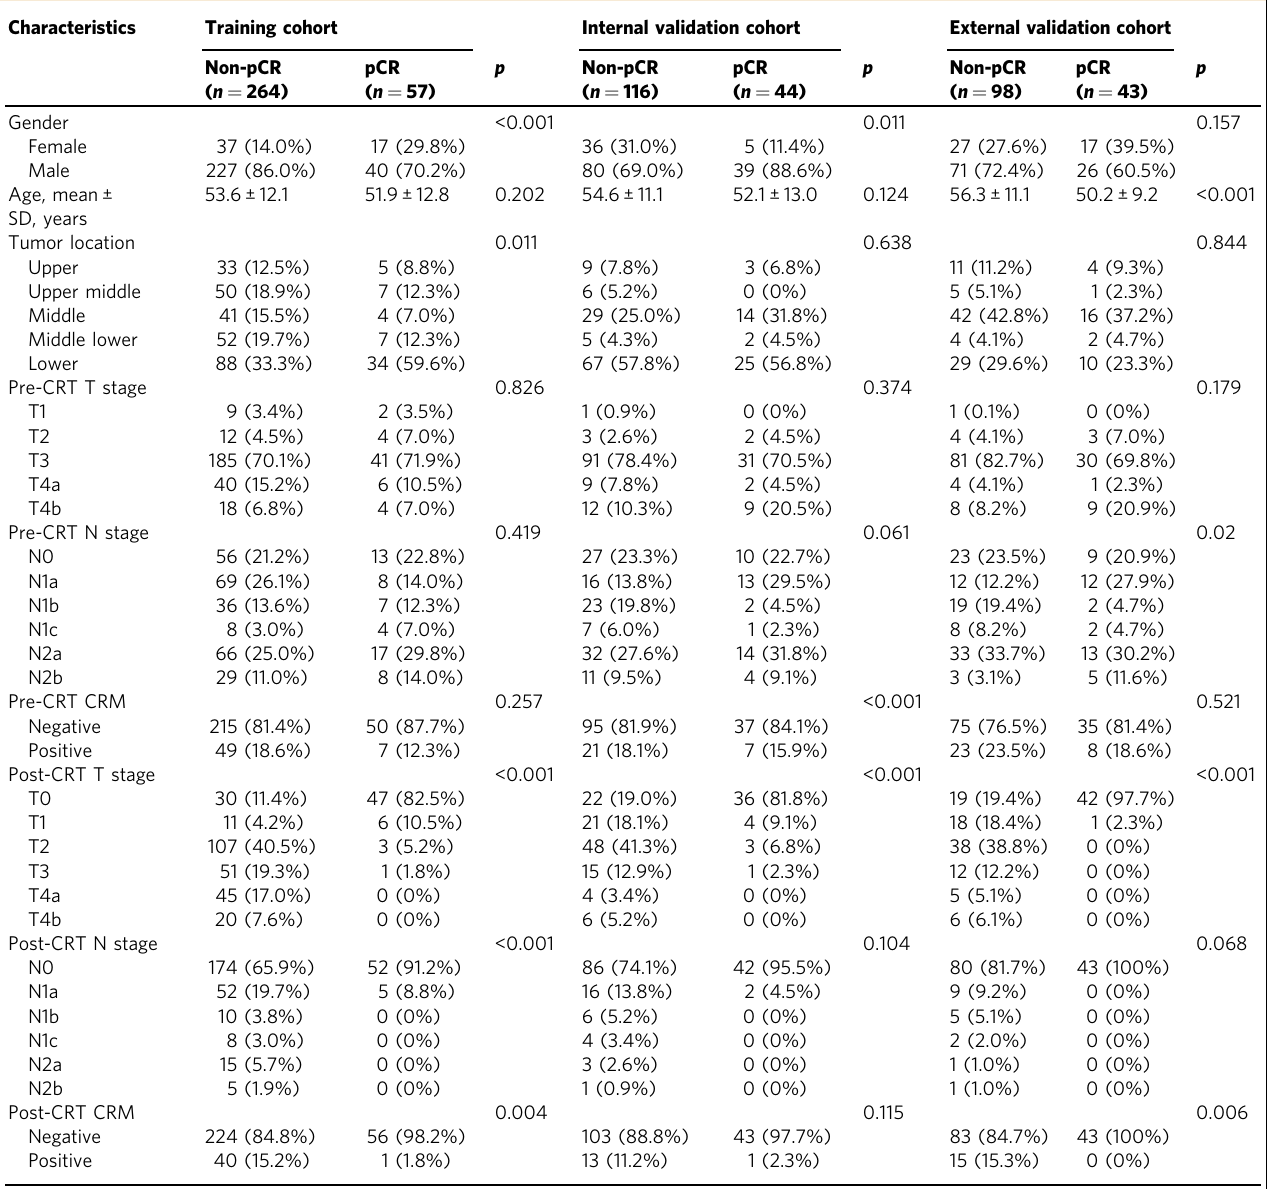
Table 1 Patient characteristics in the training, internal validation, and external validation cohorts.